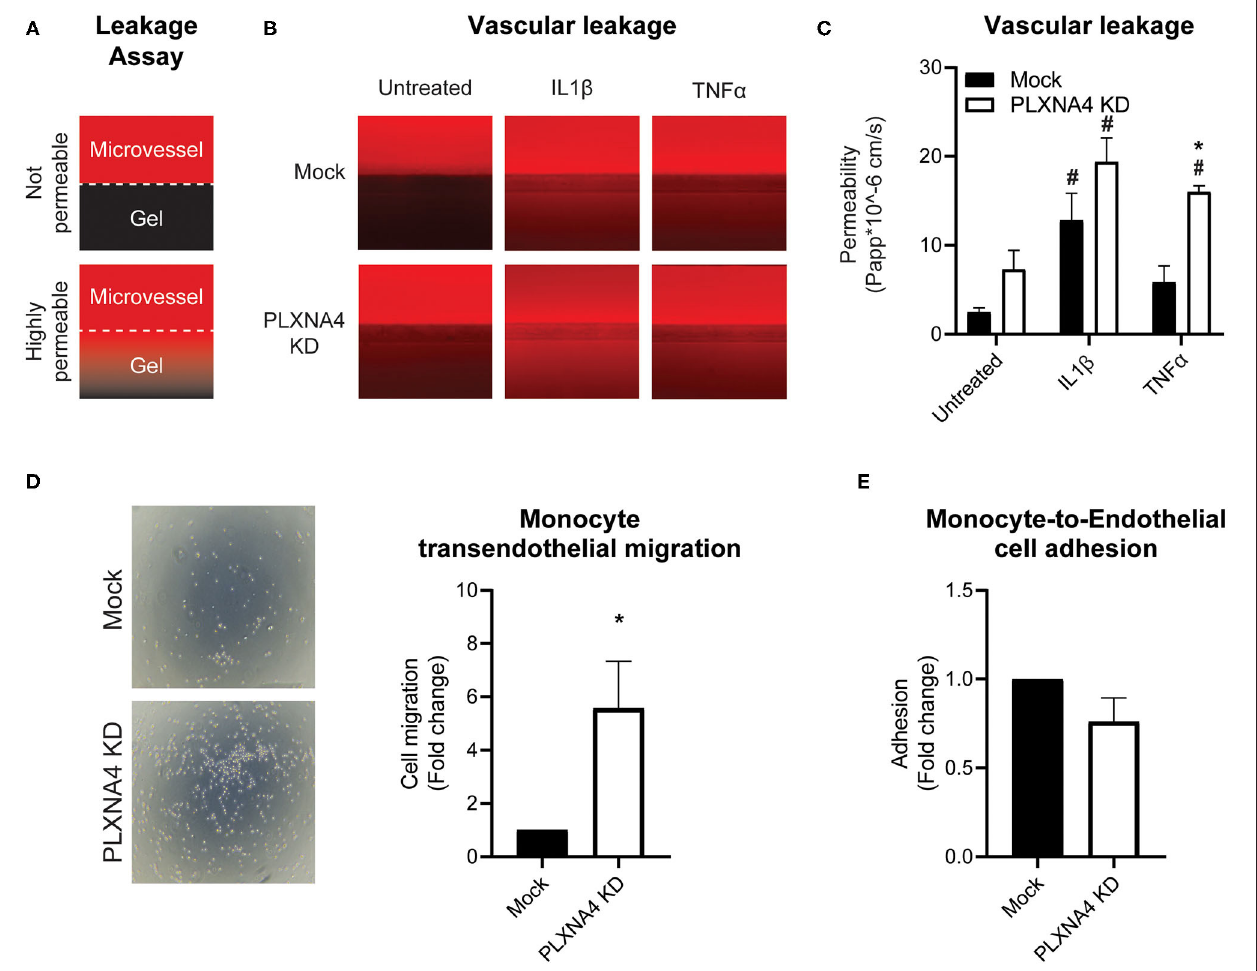
FIGURE 5 | Loss of endothelial PLXNA4 induces vascular permeability. (A) Schematic overview of the leakage assay principle, where 3D cultured capillary-like vessels in the upper perfusion channel are separated from the collagen gel in the lower channel with a phaseguide. Leak tight capillary-like vessels will have no to limited leakage of red fluorescent-labeled albumin from the perfusion channel to the gel, while increased permeability of capillary-like vessels will result in increased fluorescent signal in the gel channel. (B) Representative overview photographs and (C) quantification of the apparent permeability of capillary-like vessels composed of endothelial cells with normal or decreased expression of PLXNA4 and with or without IL1 β (20ng/mL) or TNF α (10ng/mL) stimulation. Mean ± S.E.M. of N = 4, * P < 0.05 for mock transduced cells vs. PLXNA4 KD cells # P < 0.05 for stimulated cells vs. untreated cells. (D) Representative overview pictures and quantification of migrated monocytes through a monolayer of mock or PLXNA4 KD endothelial cells toward MCP-1. Results are relative to mock control cells, set at 1. Mean ± S.E.M. of N = 8. (E) Quantification of adhered fluorescently labeled monocytes to mock and PLXNA4 KD endothelial cells. Results are relative to mock control cells, set at 1. Mean ± S.E.M. of N =